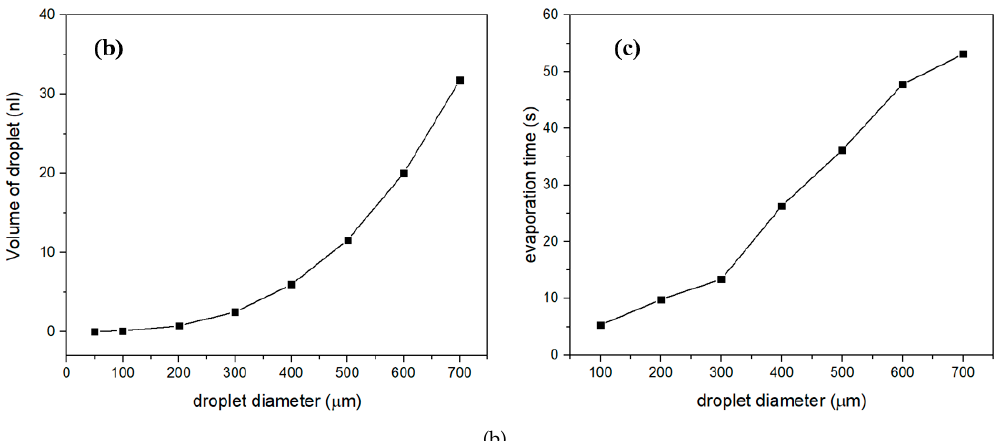
Figure 2. ( a ) Cross-sectional view of a surface-tension-confined droplet. ( b ) The relation between the droplet volume and droplet diameter. ( c ) The time required for evaporation of droplets with different diameters (25 °C, 30%RH).